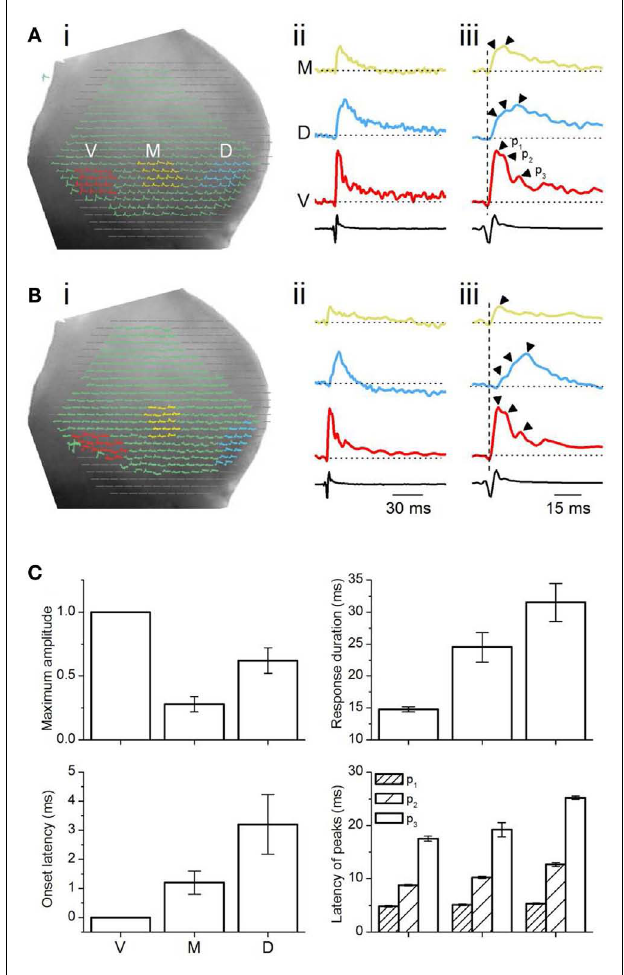
FIGURE 4 |Analysis of multi-pixel responses in the transverse plane. (A,B) (i)Two slices illustrating different sets of 16pixels chosen in the ventral (red), medial (yellow), and dorsal (light blue) regions of the ICC. (ii) Responses summed over the 16pixels in each area. M, medial ICC; D, dorsal ICC;V, ventral ICC. (iii) Expanded illustrations of the traces in (ii). Arrowheads by each trace: peaks in the response. p 1 , p 2 , p 3 , peak 1, peak 2, peak 3; Dotted vertical line, time of response onset in the ventral ICC. Scale bars apply to traces in (A,B) . (C) Multi-pixel measures of maximum amplitudes, duration of response, onset latency, and times of subsequent peaks. Maximum amplitudes were measured as a fraction of the maximum amplitude in the ventral ICC. Response durations are absolute values, measured at half-maximum amplitude. Onset latencies were measured with respect to the onset of the response in the ventral ICC, which was set to zero.The latencies of peaks were measured with respect to the onset latency in each region. Each point is the average of three to four trials from each slice, further averaged over 26 slices, with the exception of p 3 in the medial ICC (average of 14 slices). Error bars are SEM.